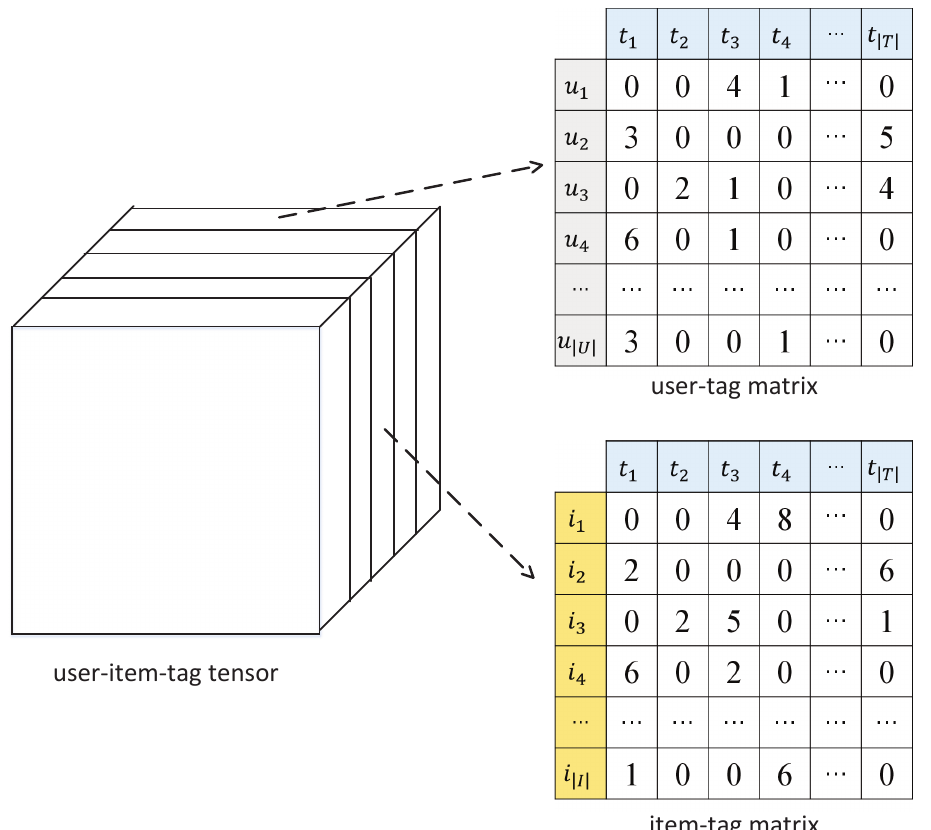
Figure 1. An example of obtaining the user–tag matrix and the item–tag matrix by decomposing the user–item–tag